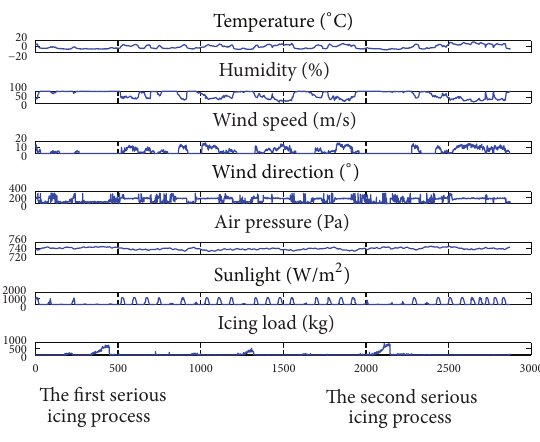
Figure 2: Meteorology data and icing load curves I (2009.12.14–